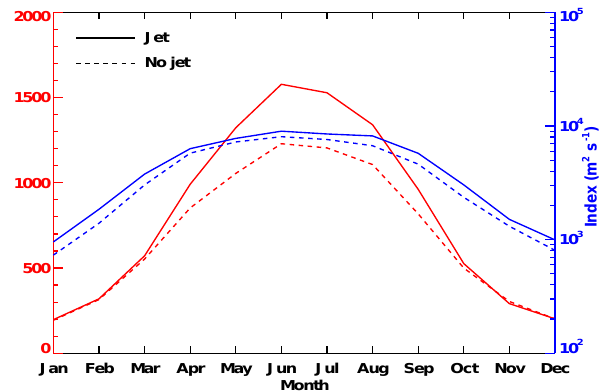
Figure 9. Monthly averaged convection boundary layer height at 06:00UTC, and momentum index at 00:00UTC over the